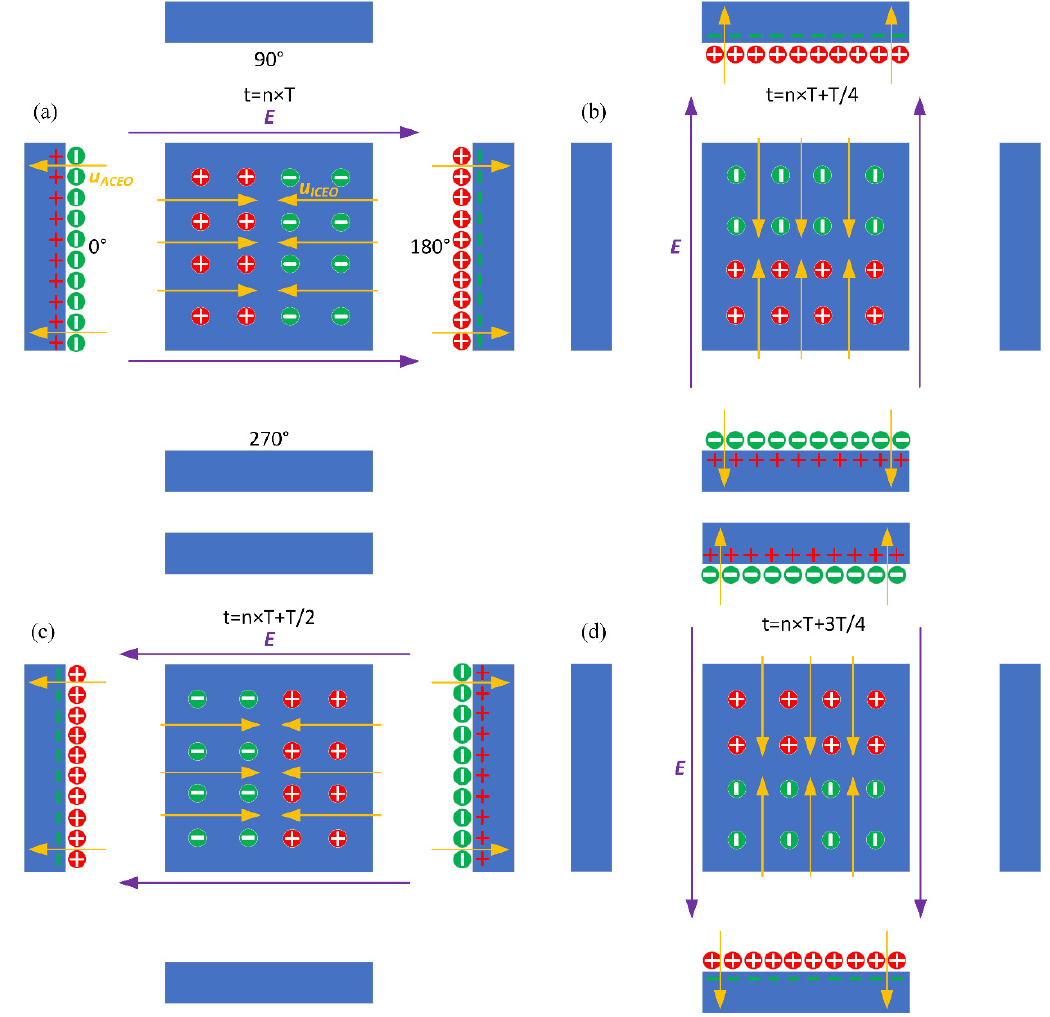
Figure 3. Theoretically-predicted bi-dimensional phase diagram of the applied rotating electric field lines, induced surface charge, and the resulted transient ROT-ICEO surface slipping flow at different time instants within a complete AC cycle for case (i): ( a ) t = nT, ( b ) t = nT + T/4, ( c ) t = nT + T/2, and ( d ) t = nT + 3T/4.